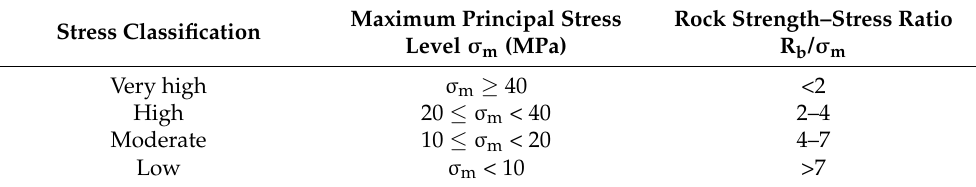
Table 2. Geostress